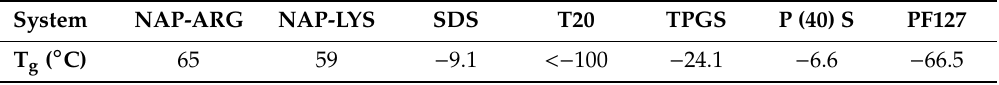
Table 1. T g s of the amorphous ball milled salts and the surfactants.